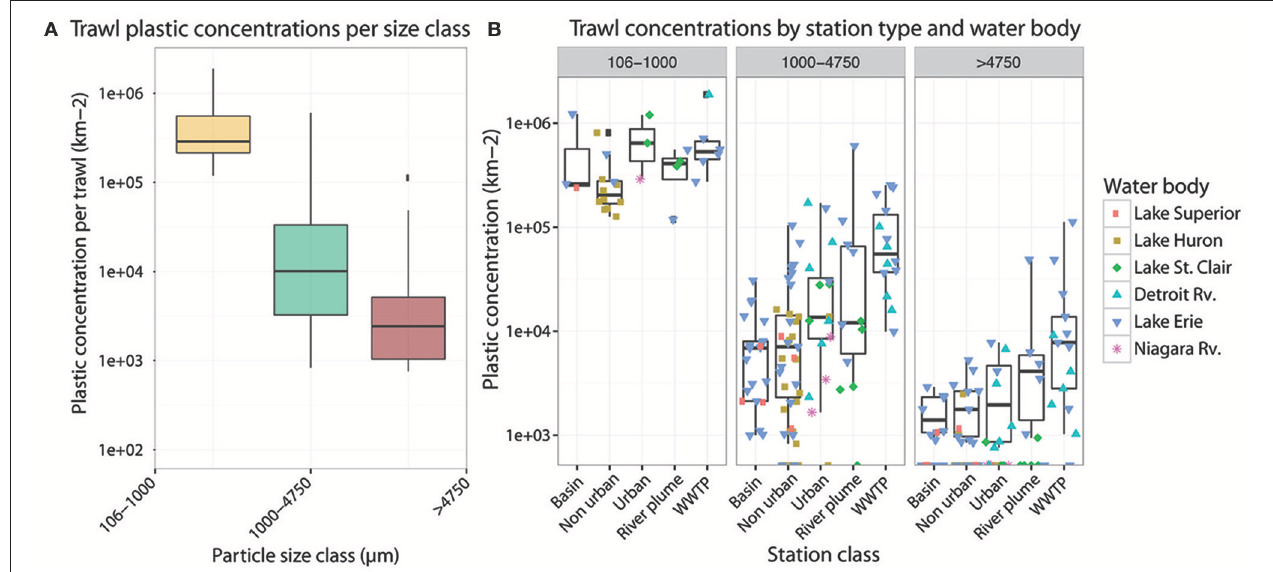
FIGURE 4 | (A) Boxplots depicting the means and spreads of all individual trawl counts by particle size fraction. (B) Boxplots depicting the means and spreads of individual trawl counts by size class, station type, and water body: Lake Superior (pink square), Lake Huron (brown square), Lake St. Clair (green diamond), the Detroit Rv. (blue upright triangle), Lake Erie (dark blue upside-down triangle), and the Niagara Rv. (purple star).